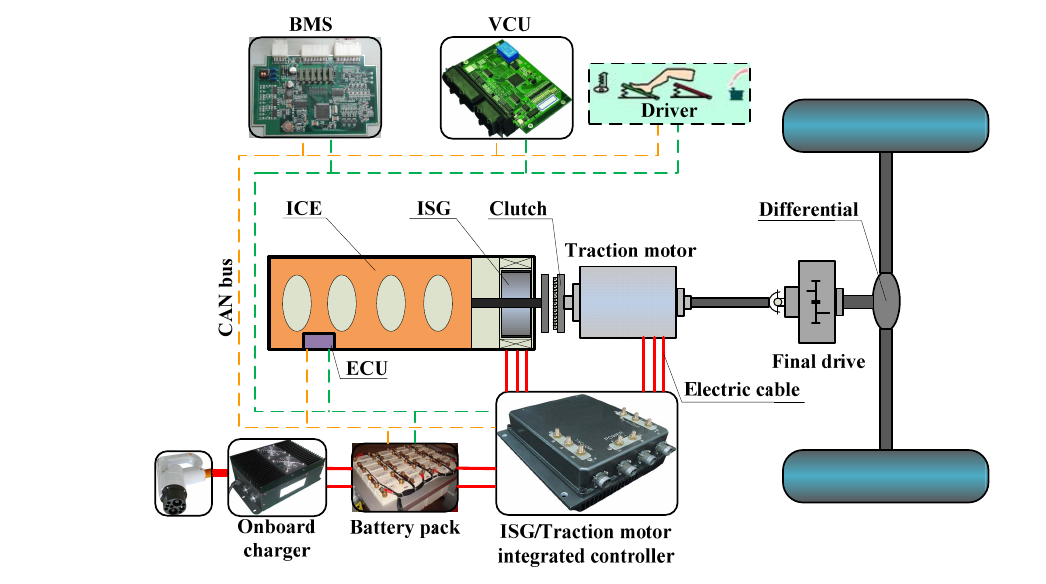
Figure 1. Powertrain configuration of the series-parallel PHEB.